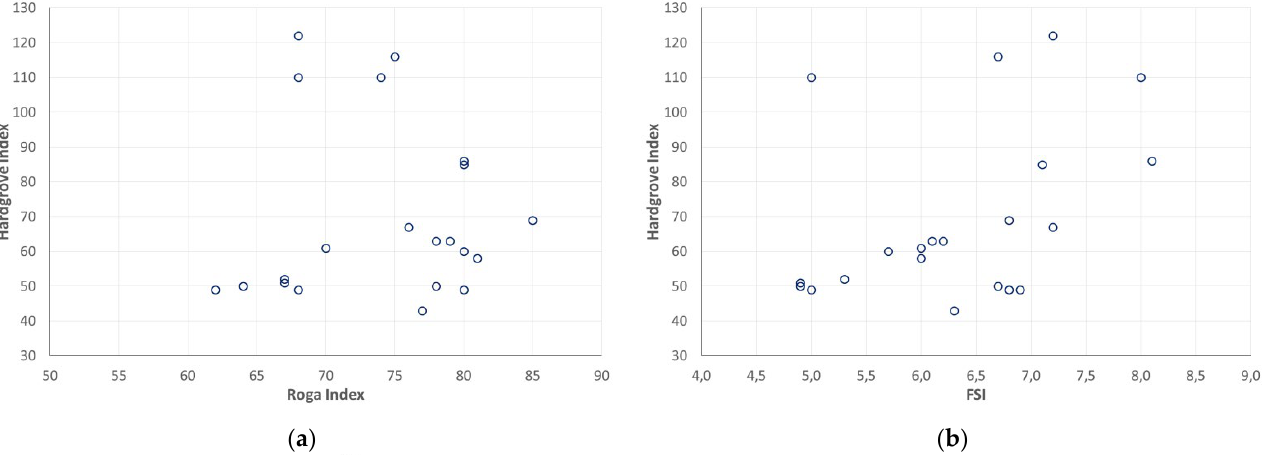
Figure 5. The value of the Hardgrove index as a function of the content of selected elements in the coals studied: ( a ) sulfur and ( b ) phosphorus.